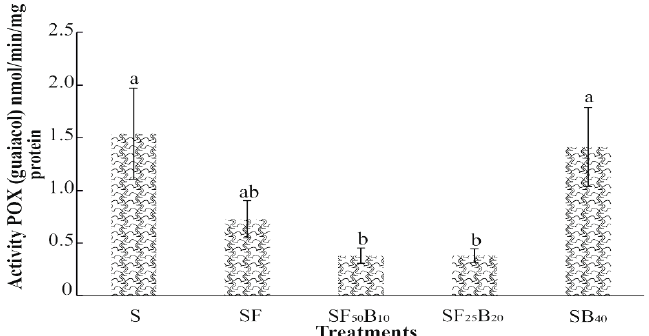
Figure 4. Peroxidase activity (POX) in basil ( Ocimum basilicum L.) cultivated in a soil with treatments, S, soil without fertilizer (control); SF, soil + fertilizer (N:P:K 100:40:40); SF 50 B 10 , soil + fertilizer